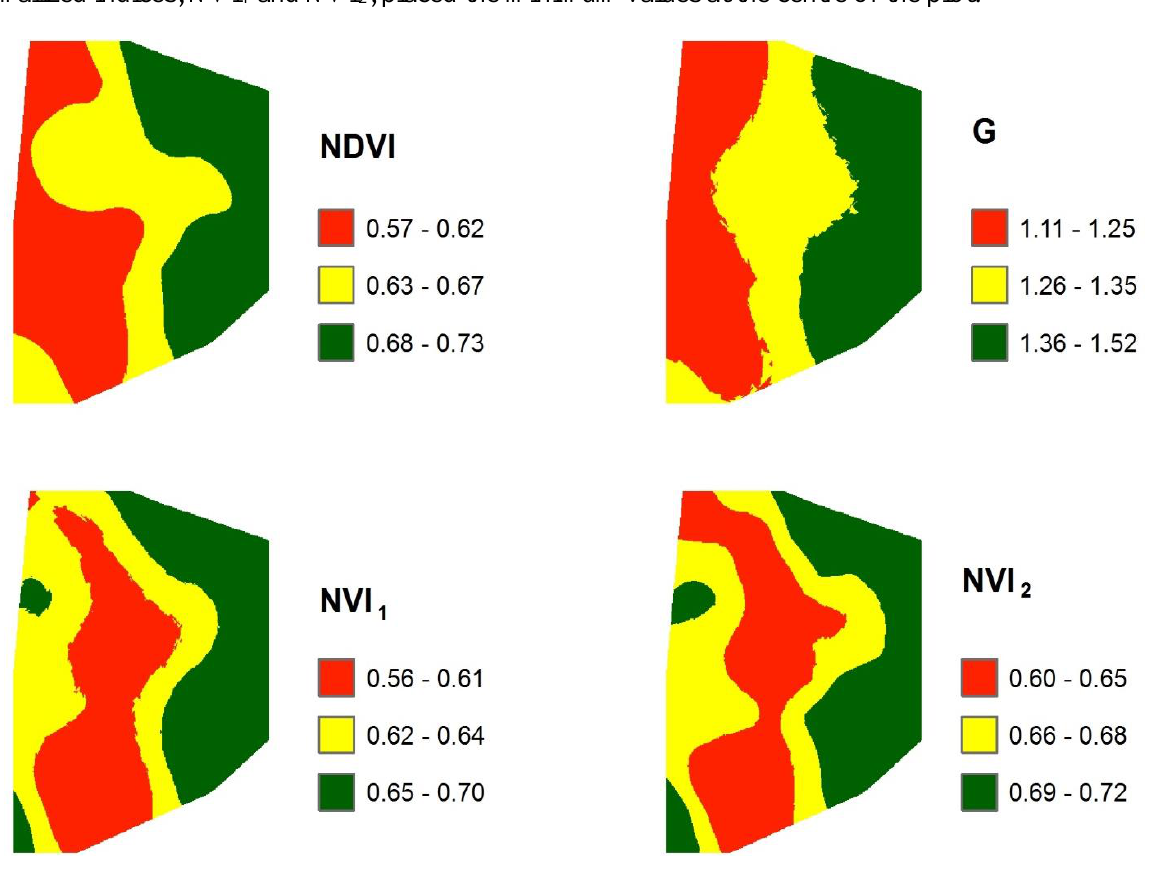
Figure 3. Maps obtained for spectral indices (NDVI, G, NVI 1 , and NVI 2 ) in a Tempranillo ( Vitis vinifera L.) vineyard. Maps were represented by